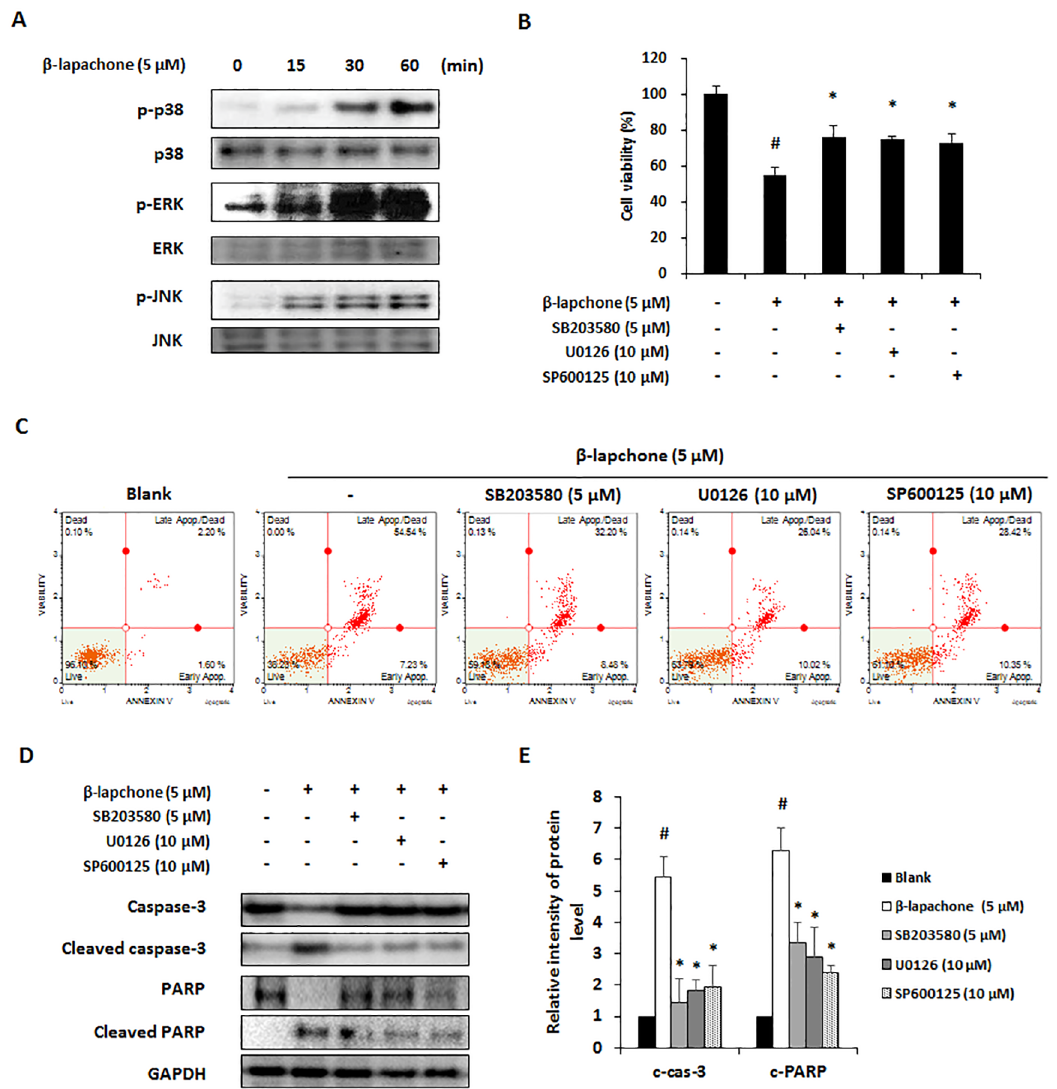
Fig 5. Effect of β -lapachone on the MAPKs pathway in B16F10 cells. (A) B16F10cells were exposedto β -lapachone (5 μ M) for 0–60min and phosphorylation levels of MAPK proteinswere determined by western blot analysis. (B and C) Role of MAPKs signalingon the β -lapachone-inducedapoptosisin B16F10 cells. Cells were pretreated with the MAPK inhibitorsSB203580(5 μ M, p38 inhibitor),U1026(10 μ M, ERK inhibitor),and SP600125(10 μ M, JNK inhibitor). After β - lapachone treatment for 24 h, cell viabilitywas determinedby WST assay (B) and AnnexinV assay (C). (D) Expressions of caspase-3 and PARP in the β -lapachone and MAPK inhibitorsSB203580,U1026, SP600125-treated B16F10cells. (E) Relativelevels of cleavedcaspase-3(c-cas-3) and cleaved PARP (c-PARP) were calculatedusing an Image J program. Valuesare the means ± SD of data from three independentexperiments. Valuesare the means ± SD of data from three independent experiments. # P < 0.05 versus β -lapachone non-treatedcells, * P < 0.05 versus only β -lapachone-treated cells.